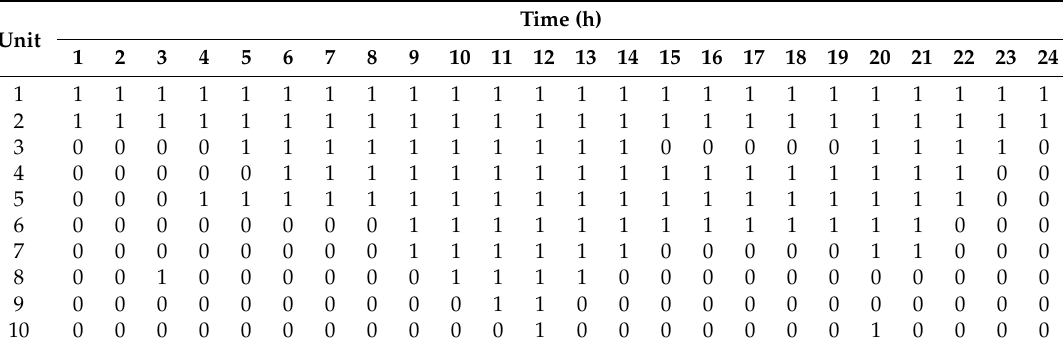
Table A1. Unit State Combination of Stc1.